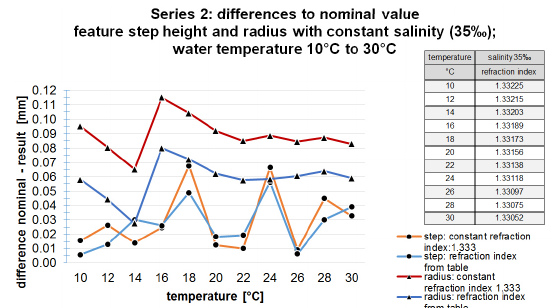
Figure 13. Results of an underwater measurement with constant salinity (35‰) and increasing